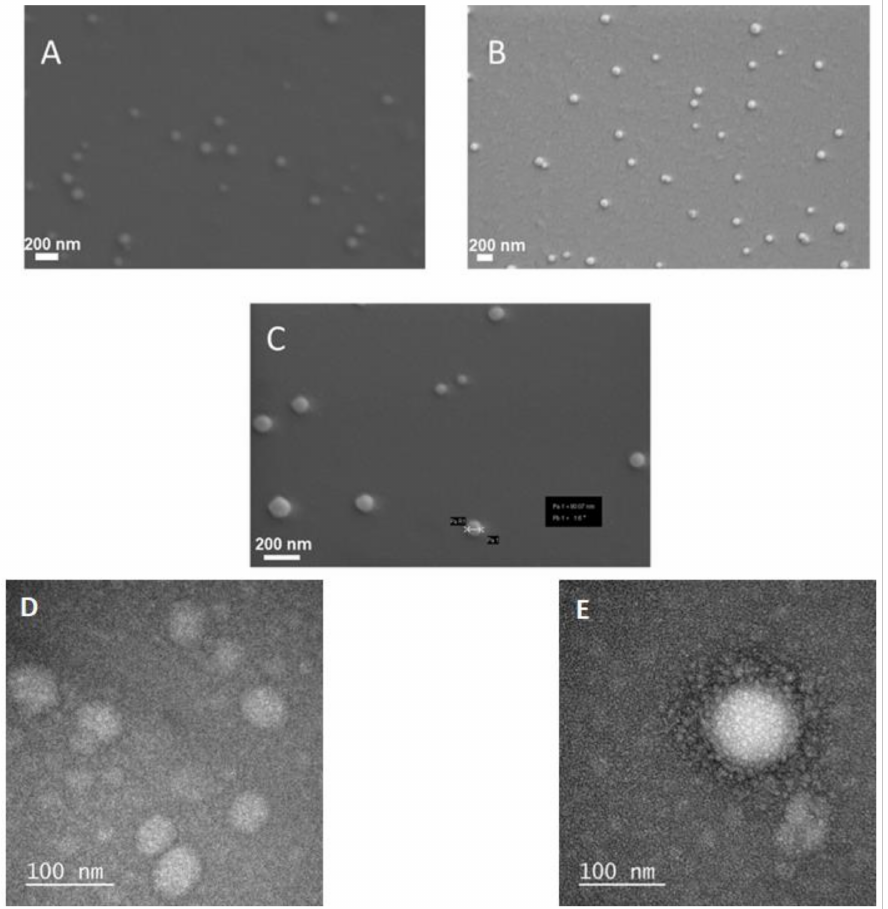
Figure 2. Electron microscopy images of different nanoparticles. FESEM image of ( A ) bare niosome, ( B ) curcumin-loaded niosomes, ( C ) chitosan-coated niosome with curcumin and Rose Bengal. TEM images of ( D ) bare niosome and ( E ) chitosan coated niosome with curcumin and Rose